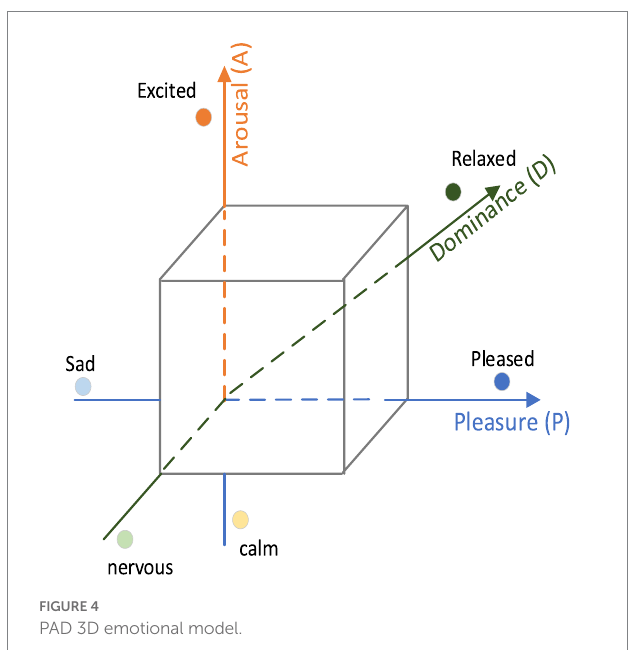
FIGURE 4 PAD 3D emotional